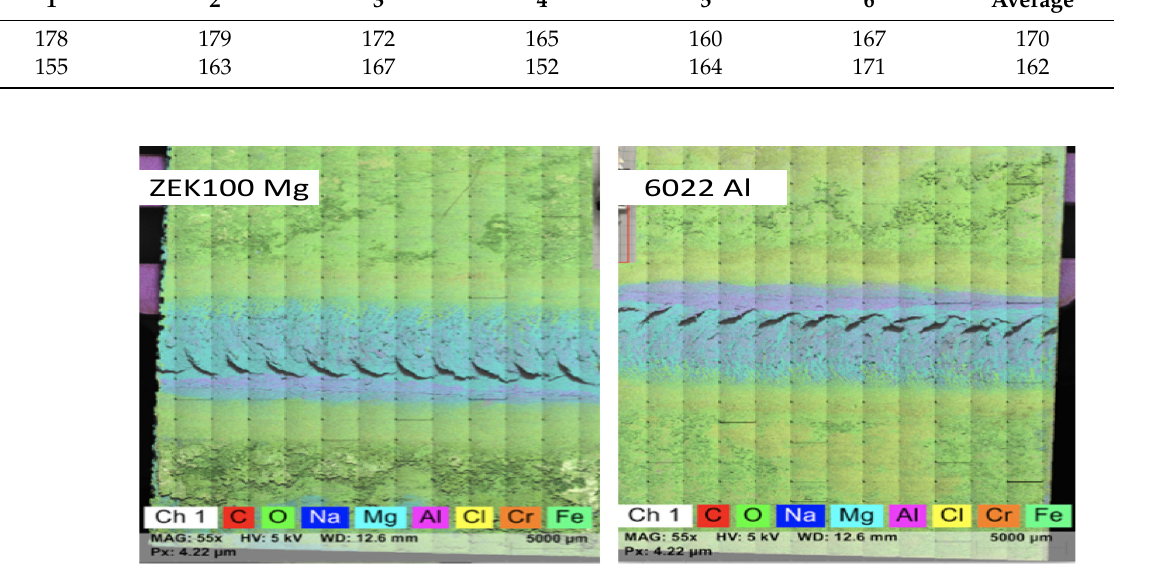
Figure 15. Large area EDS mapping of ZEK100 Mg ( left ) and 6022 Al ( right ) on detached FSW specimens after eight weeks of cyclic corrosion testing.